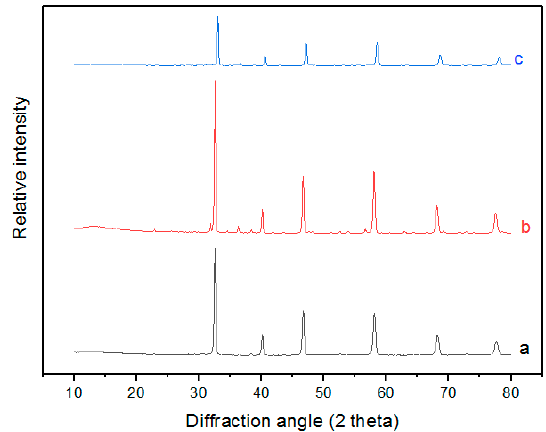
Figure 1. X-ray diffraction ( XRD) patterns of ( a ) La 0.2 Sr 0.25 Ca 0.45 TiO 3 −δ (LSCT A- ), ( b ) La 0.2 Sr 0.25 Ca 0.45 Ti 0.95 Zn 0.05 O 3 −δ (LSCTZ5) (air), and ( c ) LSCTZ5 (reduced), synthesized via the solution phase Pechini method.